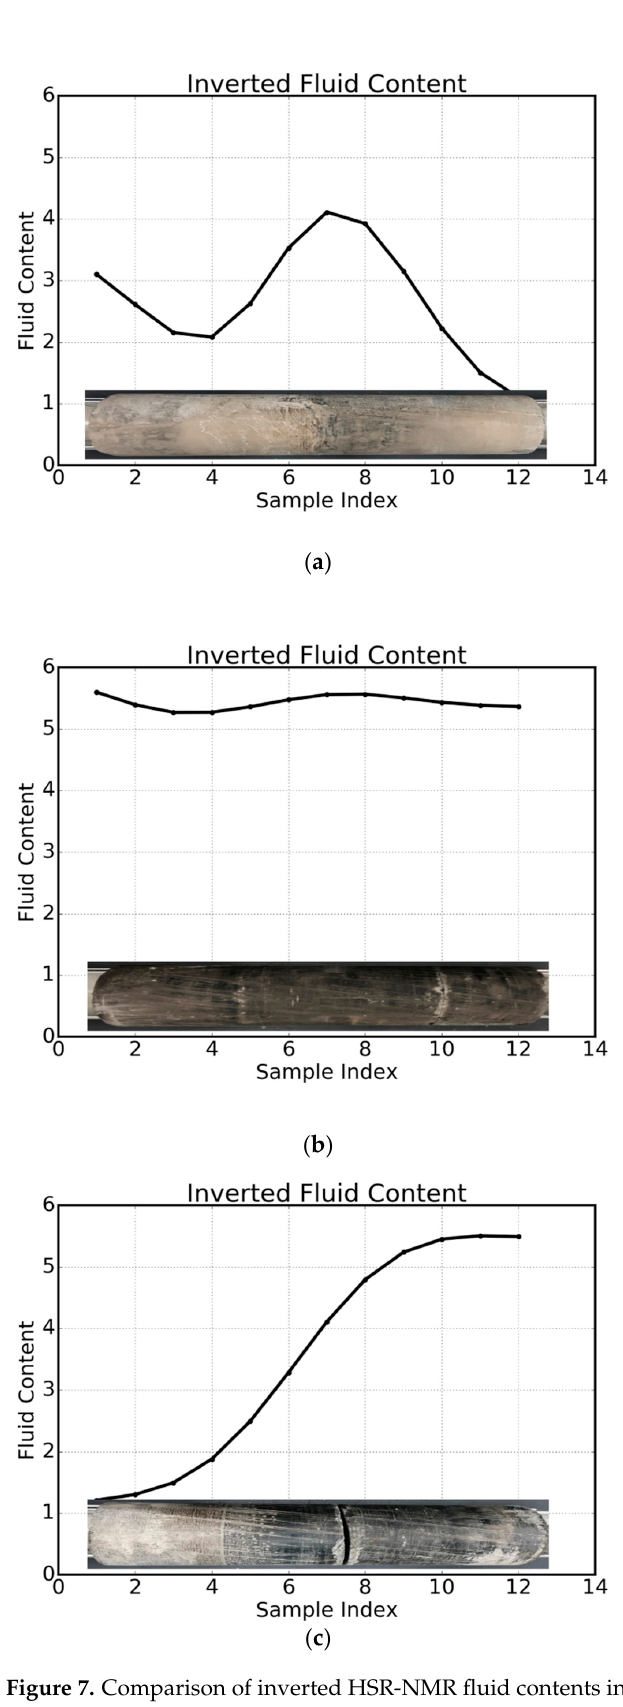
Figure 7. Comparison of inverted HSR-NMR fluid contents in the whole cores with the photos for three cores ( a–c